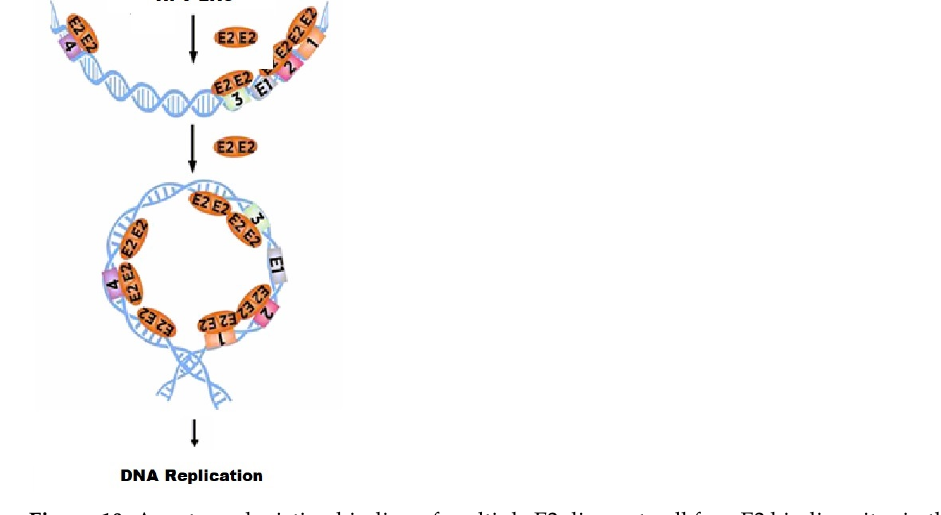
Figure 10. A cartoon depicting binding of multiple E2 dimers to all four E2 binding sites in the HPV LRC leading to the activation of DNA replication